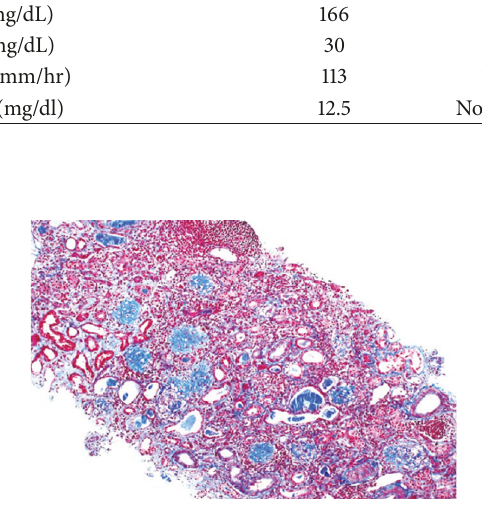
Figure 2: Trichrome stain showing global